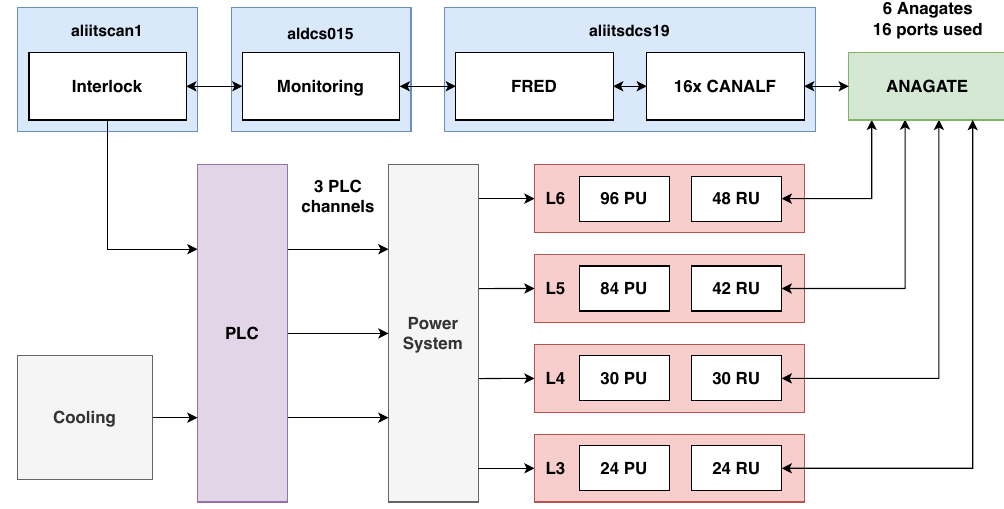
Figure 8. Schematic representation of the software interlock system for the Outer Barrel of the